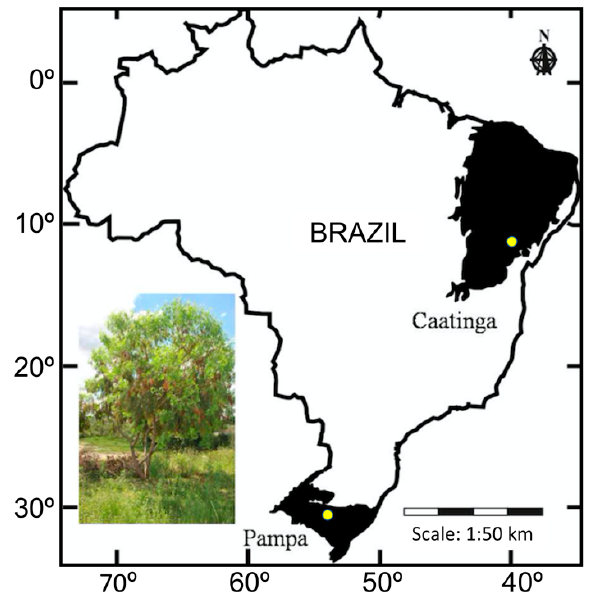
Figure 1. Location of the Pampa and Caatinga biomes in Brazil, where samples of Schinus molle were collected for this study. Dots within the biomes represent the location of each sampled population. Insert: fruiting adult tree of S. molle , within the Pampa biome.